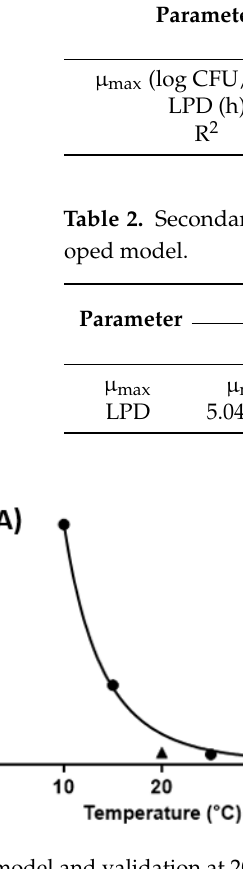
Figure 2. Secondary model and validation at 20 and 30 °C for Salmonella spp. growth in LEW. ( A ) lag phase duration (LPD); ( B ) μ max . ● : observed value for secondary model, solid line: fitted line of secondary model, ▲ : observed value for validation. Table 2. Secondary model of the growth of Salmonella spp. in LEW and validation of the devel- oped model.